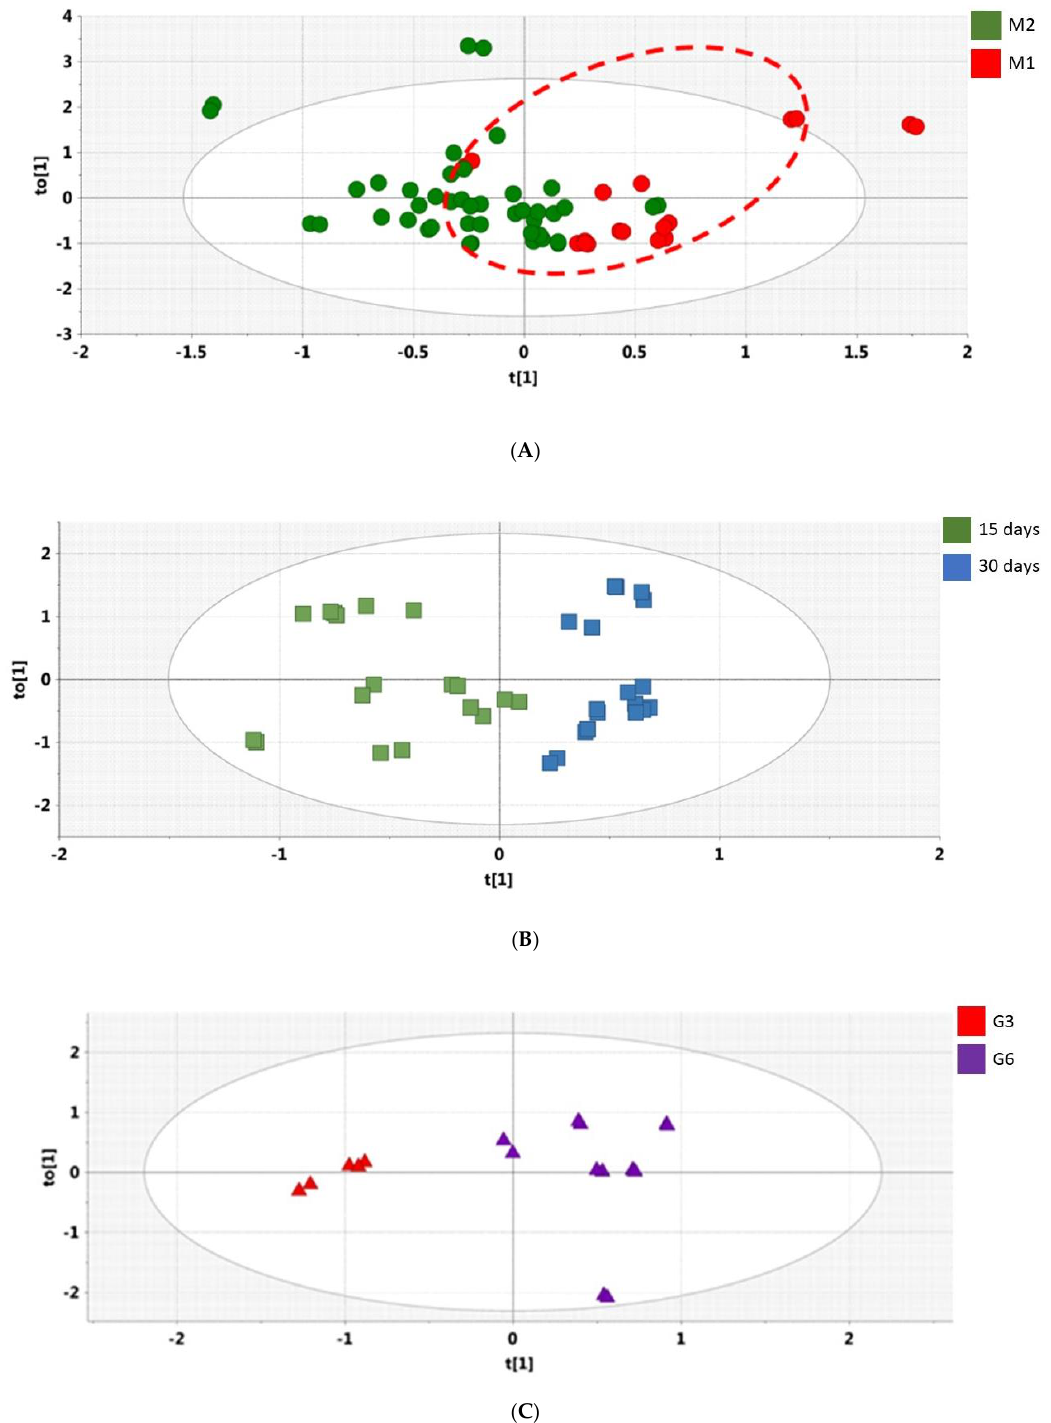
Figure 4. ( A ), OPLS-DA Scores plot for Day 15 urines vs. Day 30 urines showing UV-resistant subjects (M1; n = 9; red) and non-resistant subjects (M2; n = 20; green). Data presented as duplicate analyses; ( B ), OPLS-DA Scores plot for Day 15 urines (green) vs. Day 30 urines (blue) for UV-resistant subjects ( n = 9). Data presented as duplicate analyses; ( C ), Day 60 OPLS-DA scores plot for urine showing separation of subgroup G3 ( n = 3; red) vs. subgroup G6 ( n = 6; purple). G3 showed UV resistance on Day 30 and Day 60; G6 showed UV resistance on Day 30, but not Day 60. The difference is still apparent after the final washout period (Day 60). Data presented as duplicate